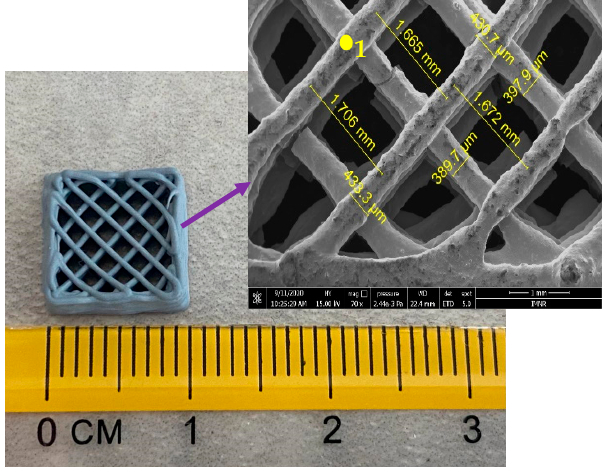
Figure 11 was: 45.1% CNT-ZnO-2 nanopowder, 26.9% HPMC, 3.4% Tween 80, and 24.6% PEI. This composition corresponds to the structure 3D-9 in Table 5.